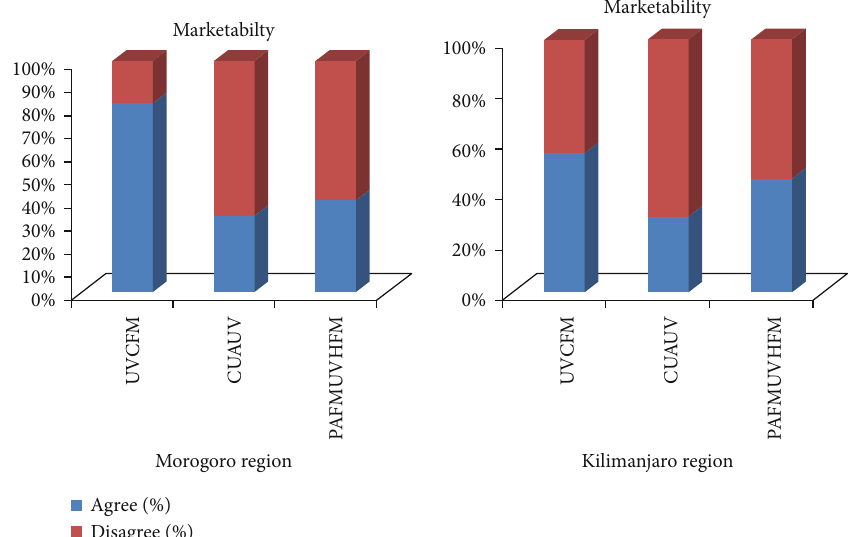
Figure 7: Marketability of the UVs. UVCFM: underutilised vegetables can be found in the market; CUAUV: consumers are unaware of the availability of underutilised vegetables; PAFMUVHFM: poor availability in the farms makes UVs hard to fi nd in the market.